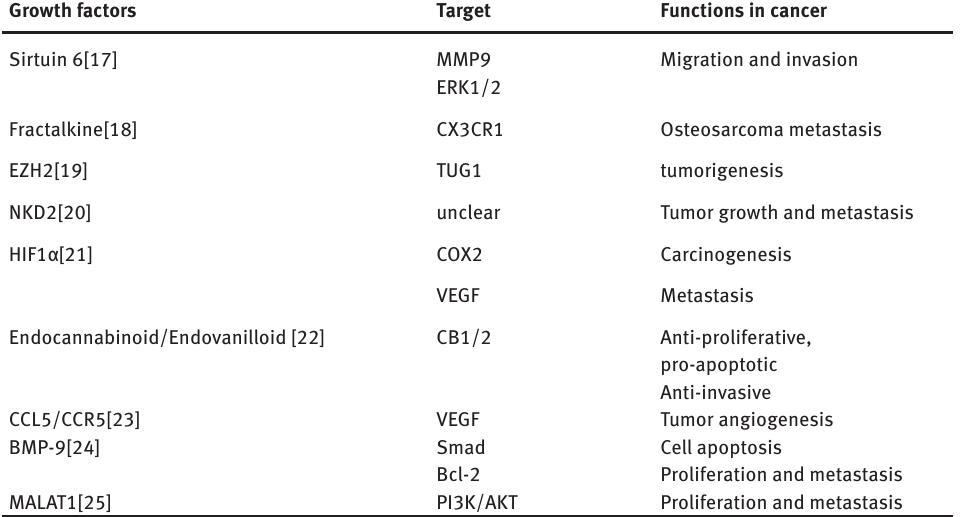
Table 1: Summary of the validated growth factors in preclinical experiments of osteosarcoma. Growth